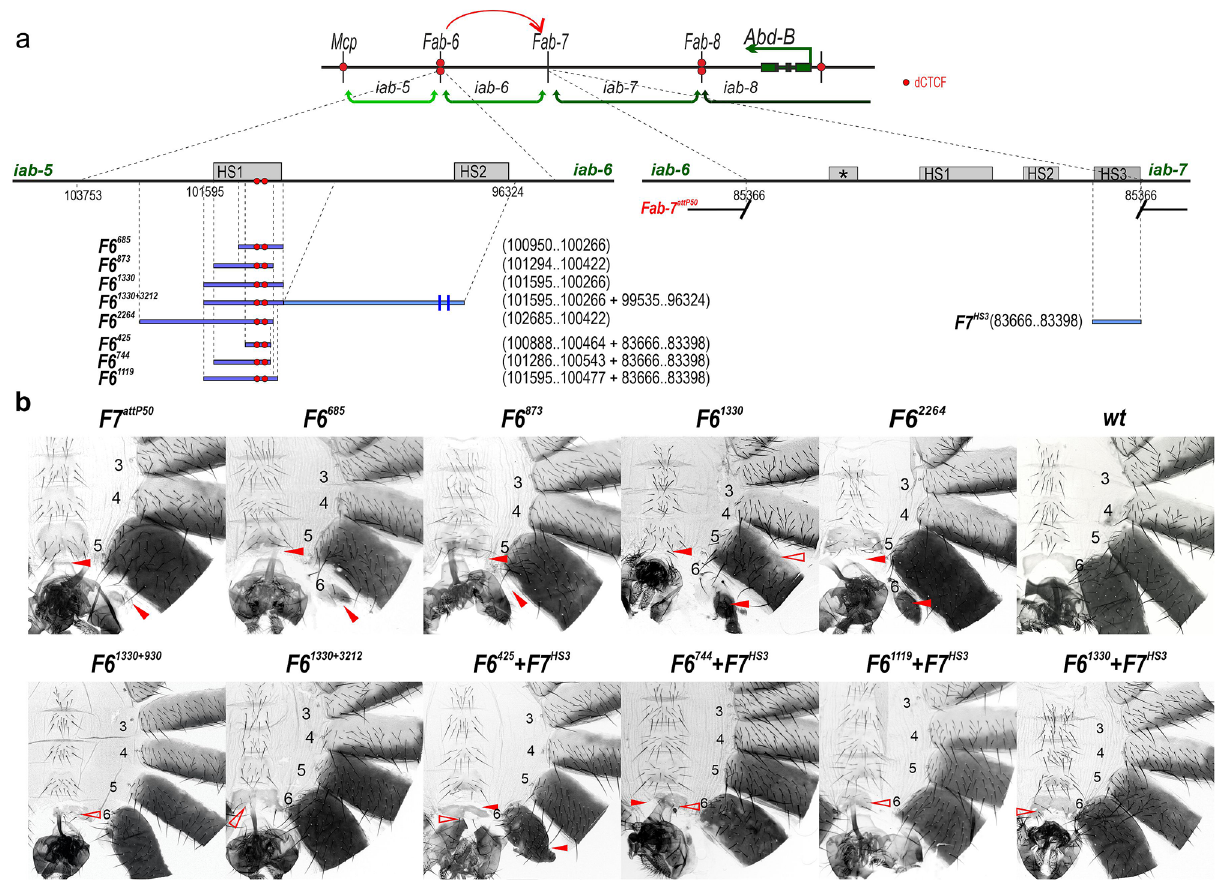
Figure 3. Fab-6 HS1 cannot substitute for Fab-7 unless it is combined with a PRE. ( a ) Maps of the Fab-6 and Fab-7 regions. The previously obtained Fab-7 attP50 deletion 27 is indicated by breaks in the black lines. ( b ) Morphology of the male abdominal segments in males with different Fab-6 replacements. All other designations are the same as described in Figs. 1 and